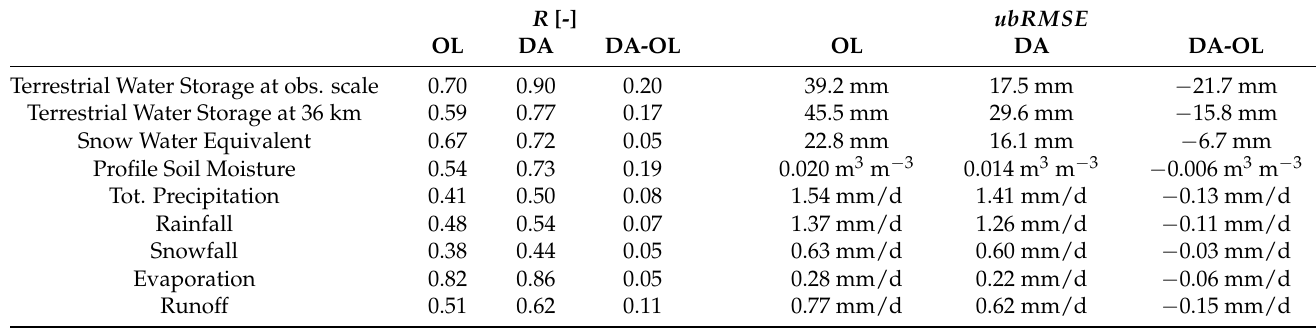
Table 1. Domain-average correlation coefficient ( R ) and unbiased root mean square error ( ubRMSE ) for open-loop (OL) and data assimilation (DA) estimates. Metrics are computed vs. the synthetic “truth” data. Confidence intervals are negligible owing to the very large sample sizes afforded by the synthetic experiment setup; statistics are computed for 156 months and averaged over 63,392 grid cells. Values for snowfall and snow water equivalent are calculated after masking impossible snow areas according to